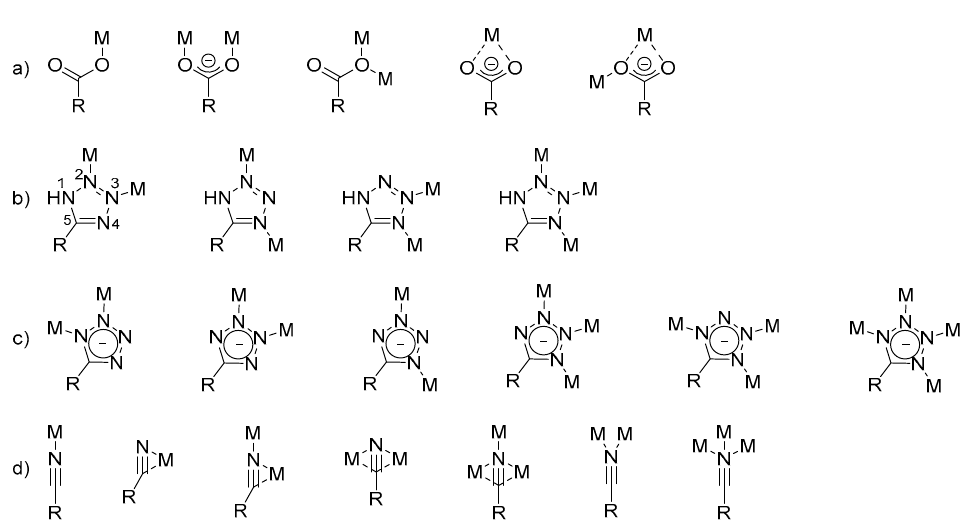
Figure 1. Most common coordination modes of ( a ) carboxylates, ( b ) 5-substituted tetrazoles, ( c ) 5- substituted tetrazolates, and ( d ) nitriles. substituted tetrazolates, and ( d )